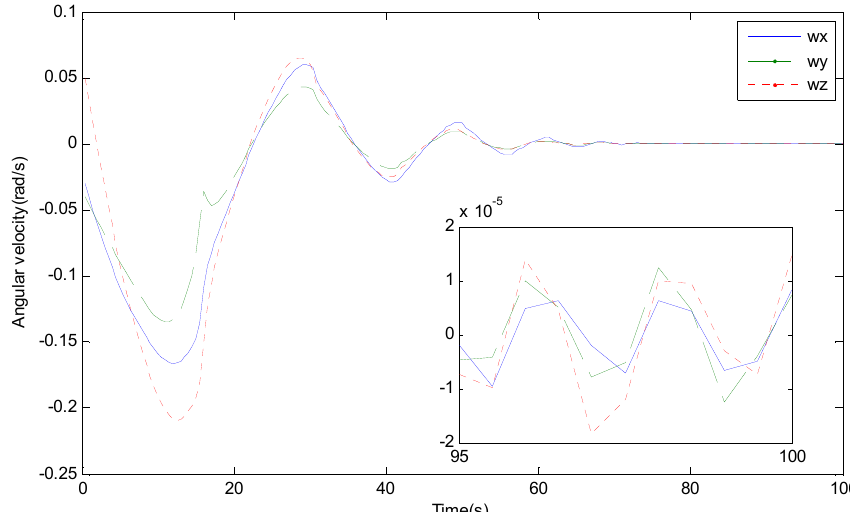
Figure 17. Curve of angular velocity.